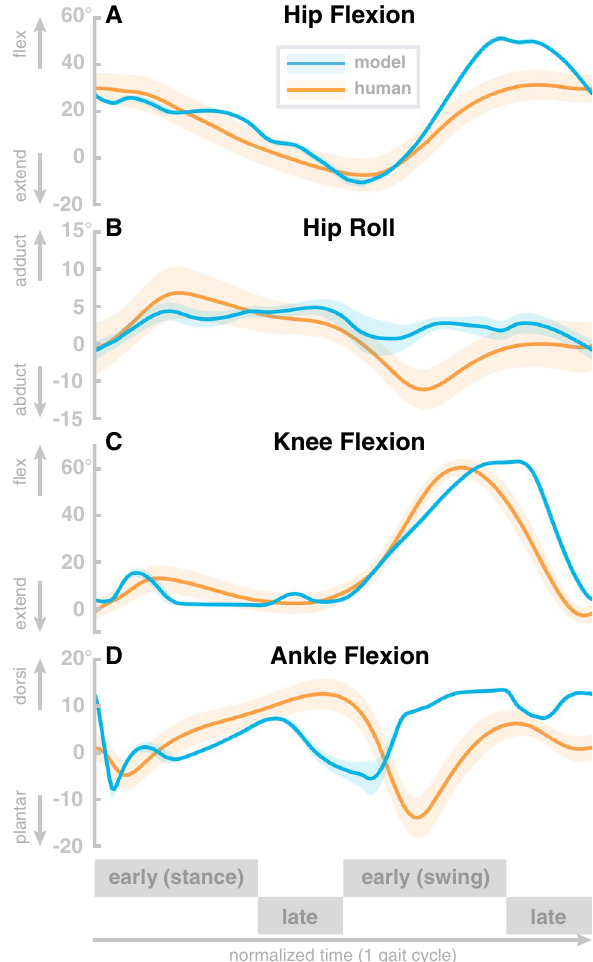
Figure 2. Comparison with human data. Averaged hip pitch, hip roll, knee and ankle joint angle trajectories for human data (orange) and model data (blue). The model data are averaged over 100 seconds of steady state walking. Human data are taken from 56 . Solid lines are means and shaded areas show standard deviation, across participants for the human data and across gait cycles for the